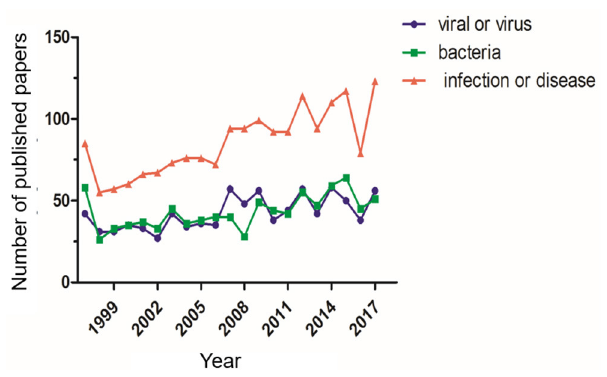
FIGURE 1 | Number of publications using Syrian hamsters as a disease model. The number of publications using Syrian hamsters as an animal model from 1997 through 2017 is shown. For each standard, the number of publications was determined via a search using the ScienceDirect database. The search was performed with the keywords “Syrian hamster” or “golden hamster” AND “model” AND (1) “viral” or “virus,” (2) “bacteria,” (3) “infection” or “disease”.